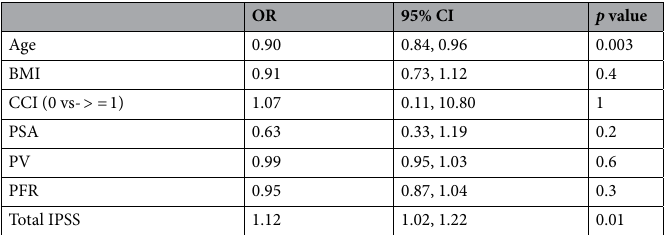
Table 3. Logistic regression analysis testing predictors of PBNO. Keys: PBNO = primary bladder neck obstruction; BMI = body mass index; CCI = Charlson comorbidity index; PSA = prostate-specific antigen; PV = prostate volume; PFR = peak flow rate; IPSS = International Prostate Symptoms Score.